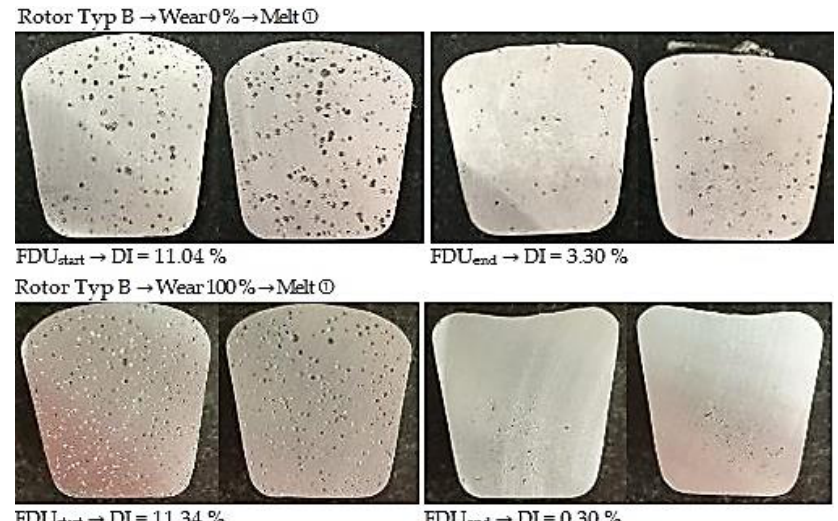
Figure 7. Comparison of degassing at 0% and 100% wear for Type B rotor. Table 12. Statistical summary of measure values of Dichte Index—type C rotor. Parameter FDU